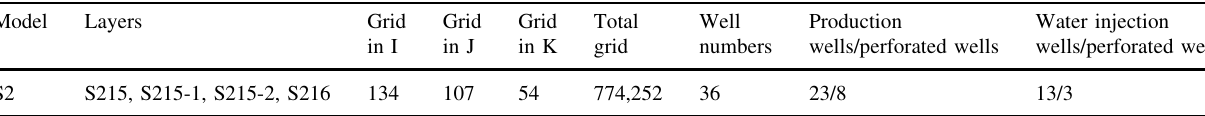
Table 1 The basic information of the model Model